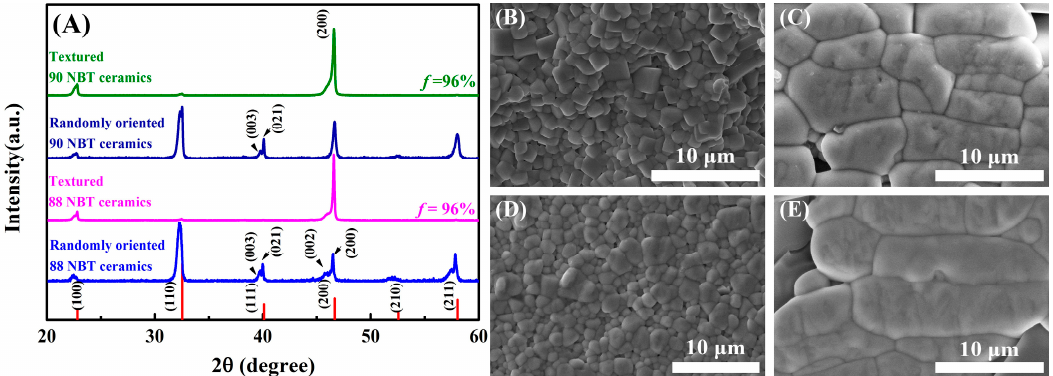
Figure 1. ( A ) XRD patterns of the randomly oriented ceramics and textured ceramics. SEM images of ( B ) randomly oriented 88NBT ceramic, ( C ) textured 88NBT ceramic, ( D ) randomly oriented 90NBT ceramic, and ( E ) textured 90NBT ceramic.